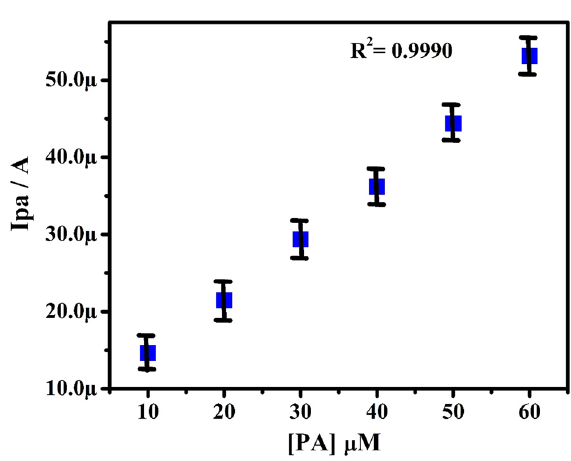
Figure 11. Graph of Ipa vs PA concentration.